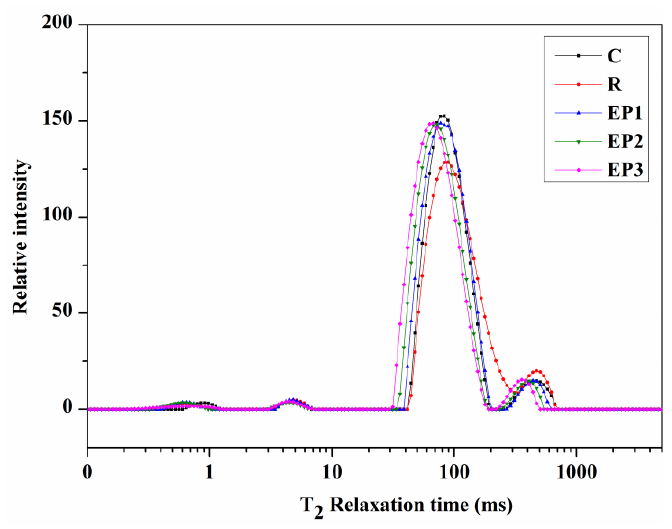
Figure 1. T 2 relaxation time distribution of